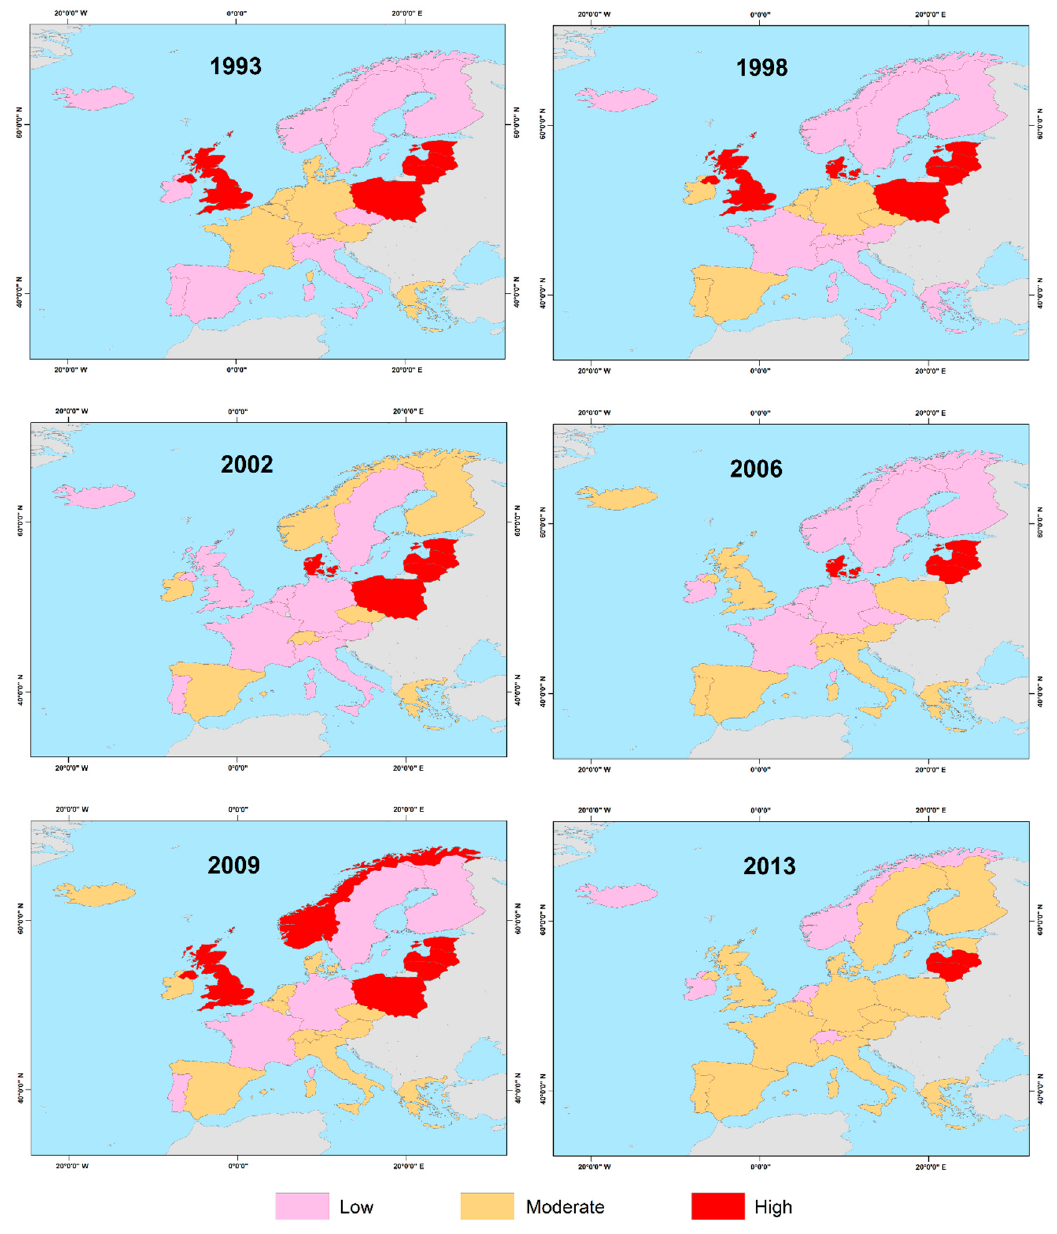
Figure 11. Population mortality due to hazardous events (parameter λ ) for female gender in 1993, 1998, 2002, 2006, 2009, and 2013.